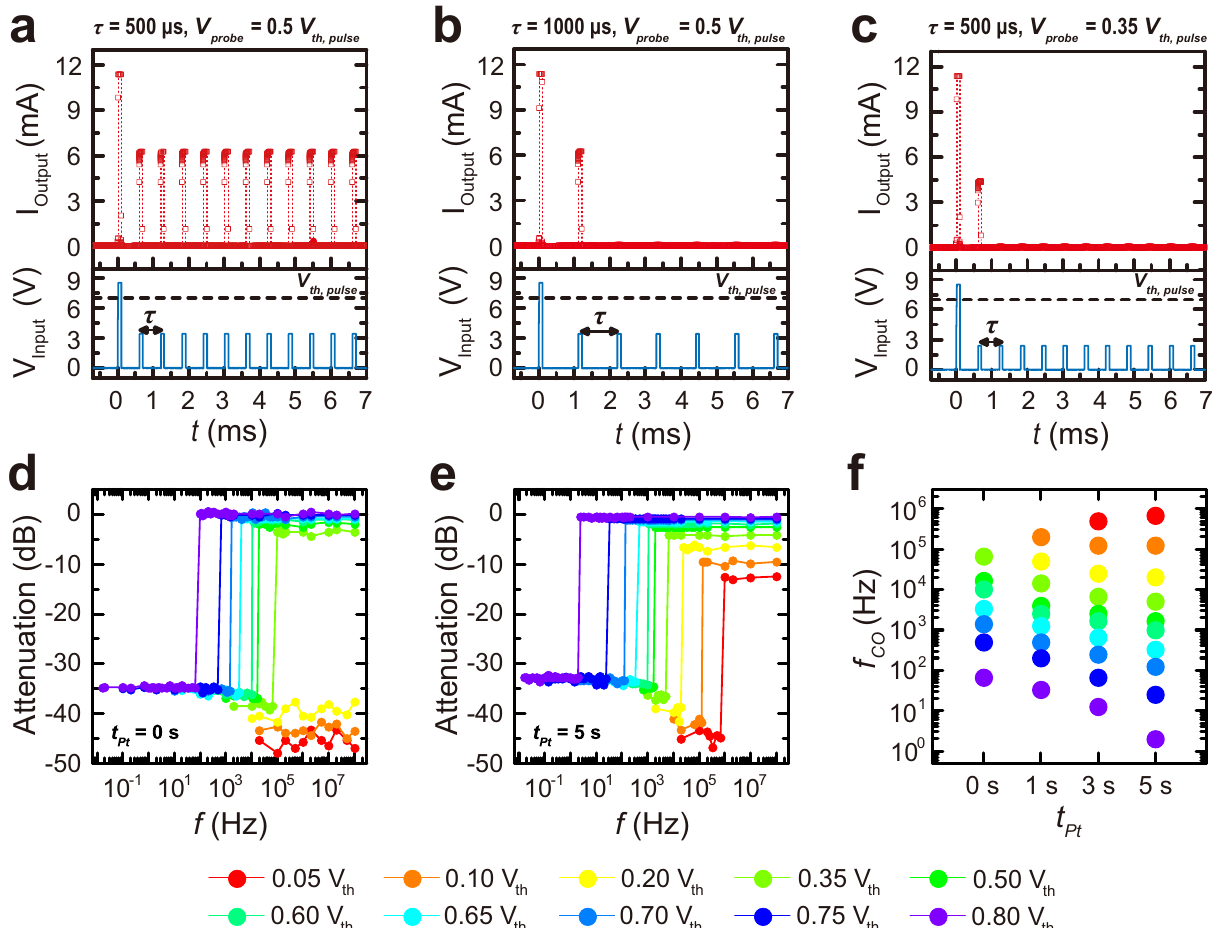
Fig. 4 | Frequency discrimination using sub-threshold fi ring ofmultiple pulses inVO 2 MottswitcheswithdifferentPtNPcoverage.a – c Transientcurrentoutput (top panels) by multiple consecutive voltage pulses with different pulse separation (or frequency, bottom panels) at T =12°C: The preceding super-threshold pulse is followed by a series of subthreshold voltage pulses separated by 500 μ s ( a , c ) or 1000 μ s. b with probe voltage amplitude of V probe =0.5 V th,pulse ( a , b ) or V probe =